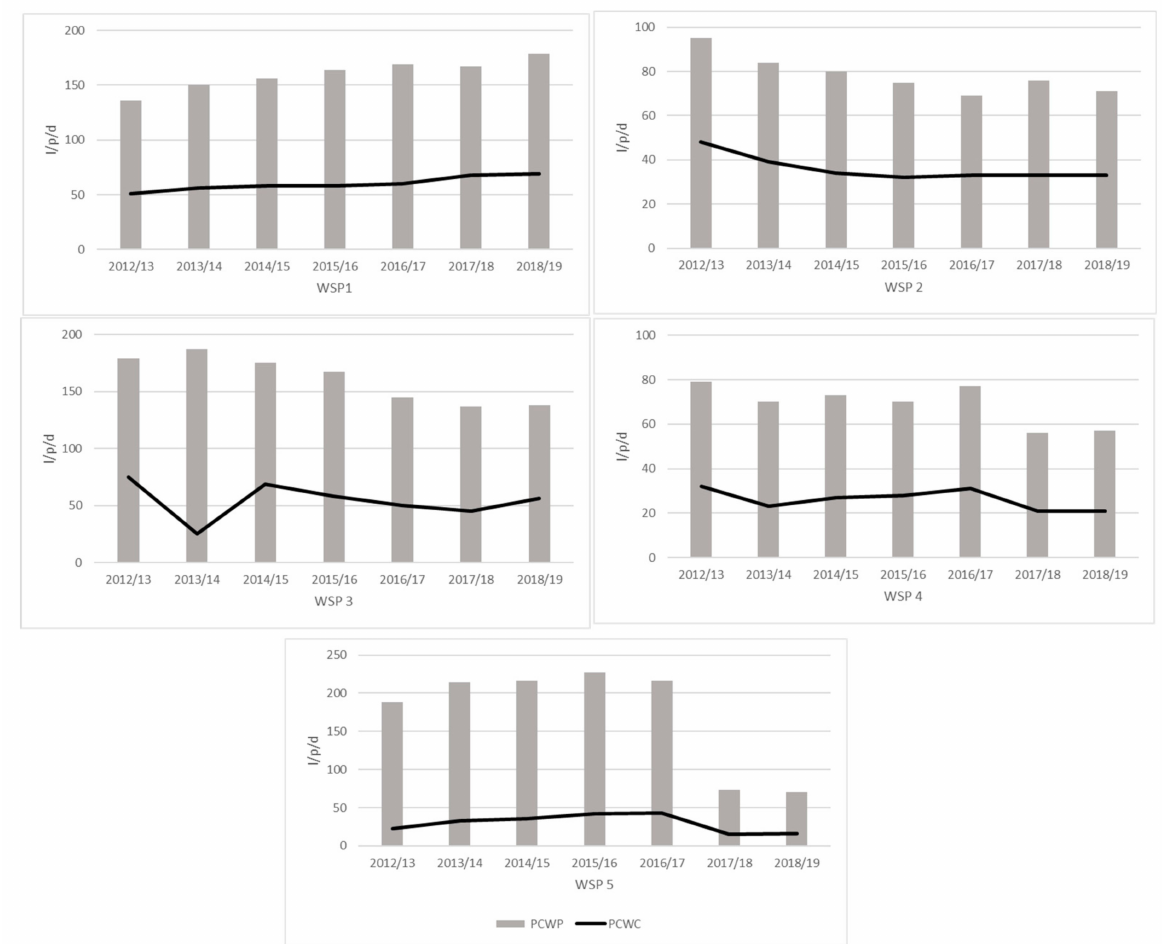
Figure 1. Seven-year trends of daily Per Capita Water Production (PCWP) and per Capita Water Consumption (PCWC) for WSP1, 2, 3, 4 & 5. (Source: Water Sector performance. Reports available at